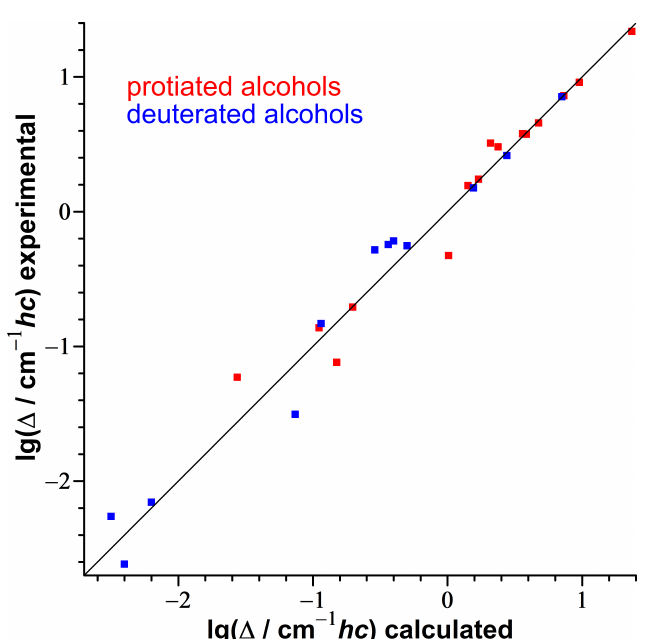
Figure 9. Correlation between logarithmized experimental tunneling splittings [20,87,94–110] and calculated ones with the 1D torsion code based on electronic B3LYP-D3(BJ)/may-cc-pVTZ potentials for 27 isotopologs of 16 symmetric alcohols. The diagonal line represents perfect agreement. Data points are given in Table S5, diagrams with torsional potentials, energy levels, probability distributions and moment of inertia for all species are available in Figures